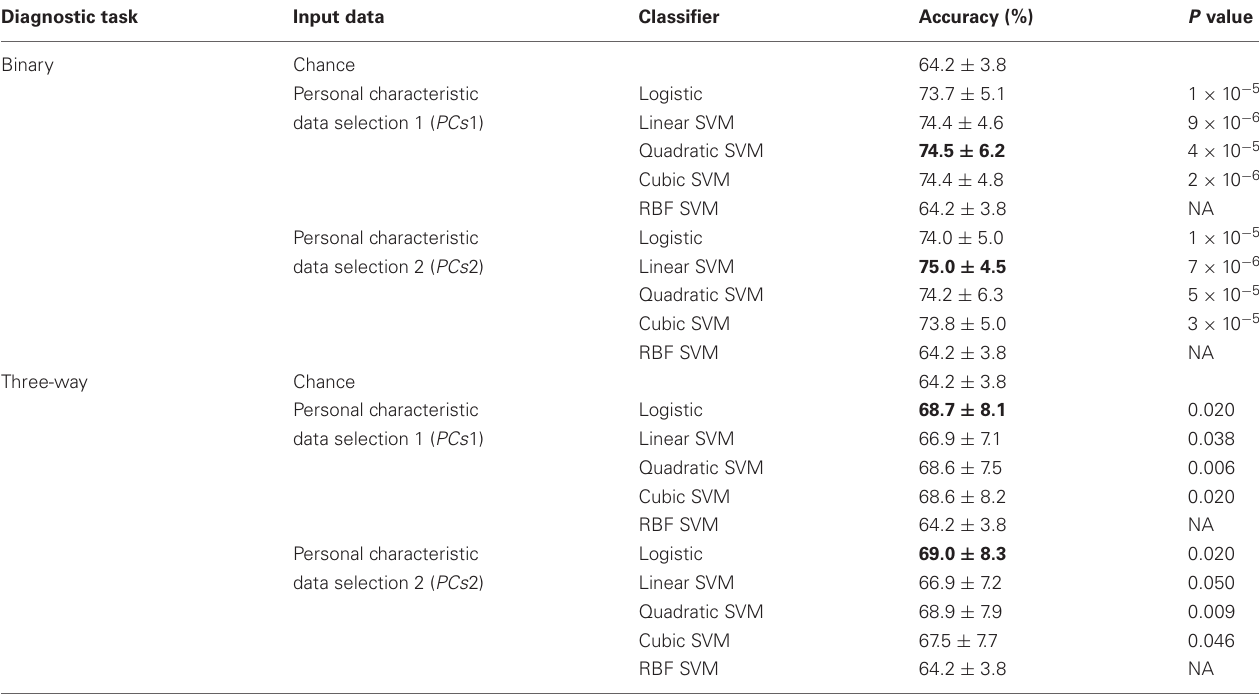
Table 3 | Training Dataset results: accuracies for binary and three-way diagnosis using various classifiers with personal characteristic data from the 668 participant Training